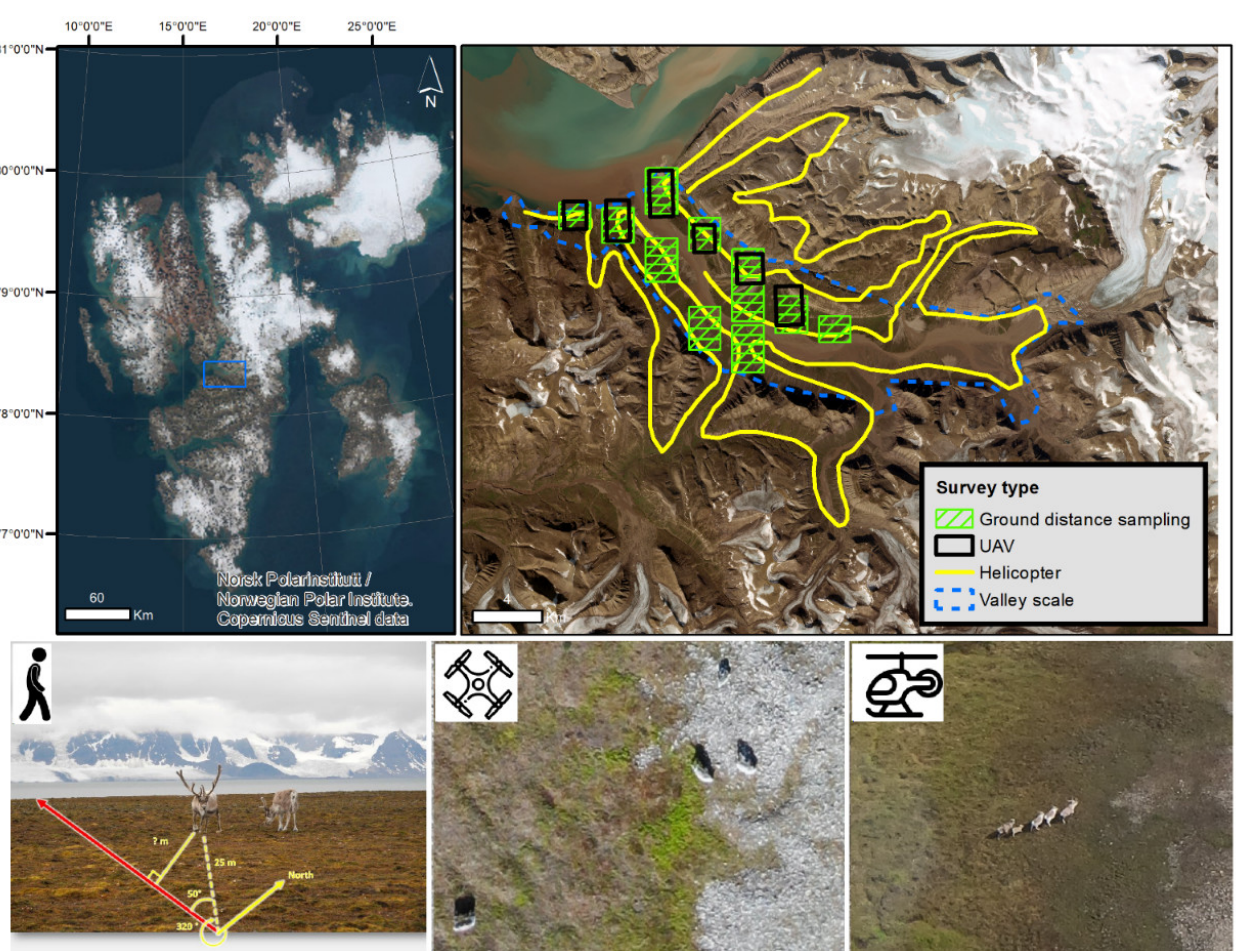
Figure 1. Upper panel: Svalbard archipelago ( left ). Overview of spatial data coverage for the three survey methods; ground DS (green), UAV (black) and helicopter (yellow) in Sassendalen, Svalbard ( right ). Lower panel: Raw images of Svalbard reindeer from the three types of survey methods. Left to right: Ground distance sampling, UAV imagery at 120 m and helicopter (photograph from side window where one observer was placed).